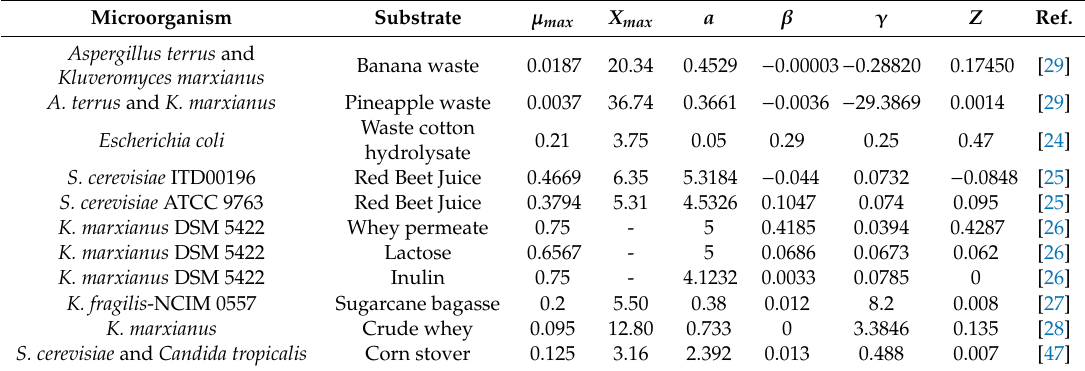
Table 3. Model parameters for di ff erent ethanol